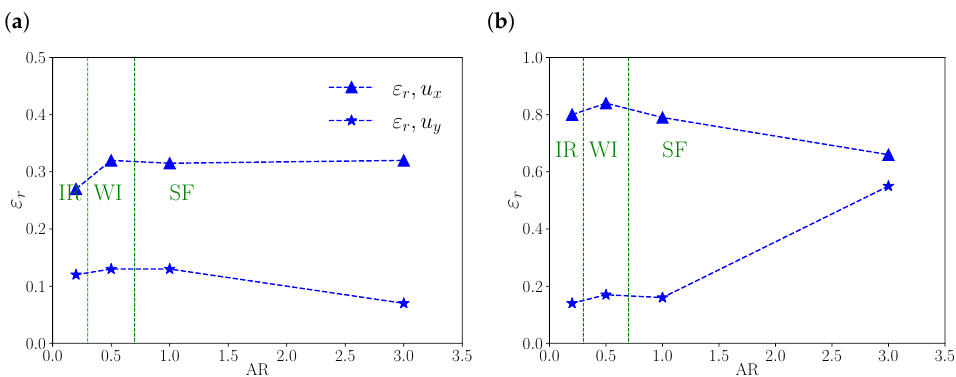
Figure 8. Variation of the canyon-averaged relative errors with AR at ( a ) θ = 45°; ( b ) θ =